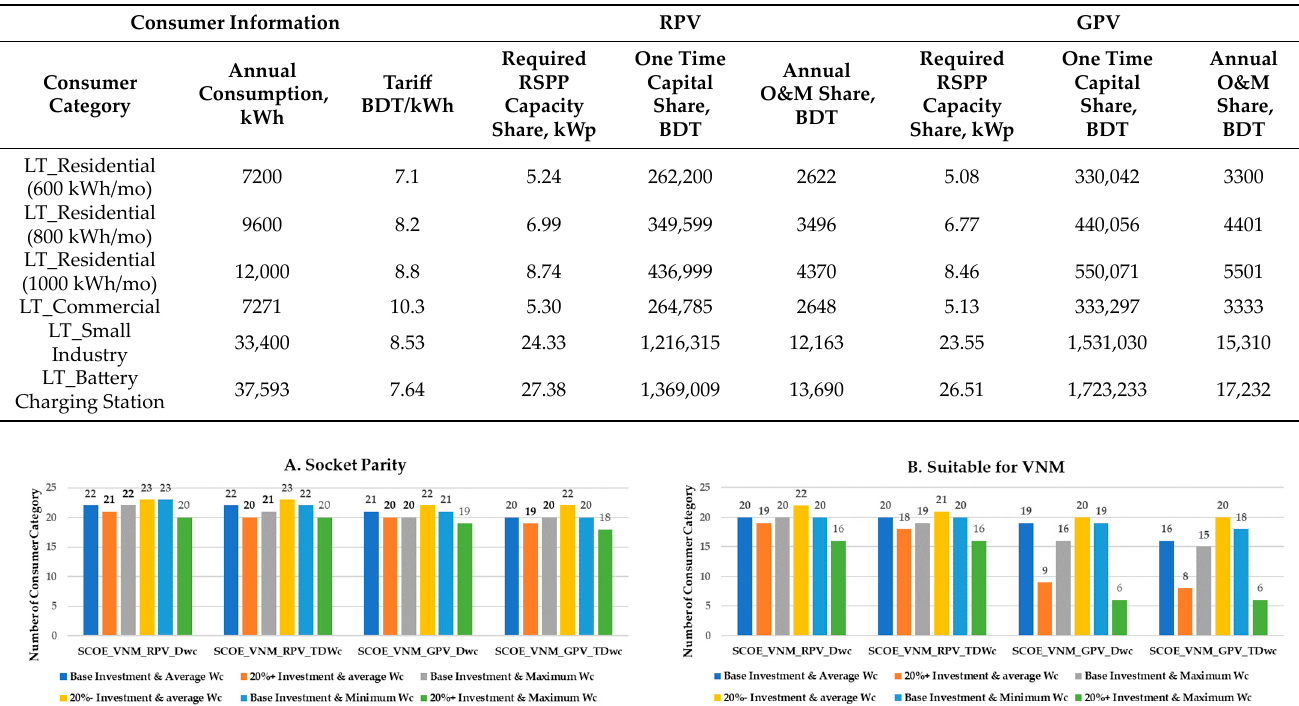
Figure 9. Impacts of investment and wheeling costs on socket parity. The base investment costs for RPV and GPV were 50,000 and 65,000 BDT/kWp, respectively. Additionally, the base wheeling costs for DWc and TDWc were 1.55 and 1.86 BDT/kWh, respectively. The minimum and maximum wheeling costs came from the wheeling costs of all the utilities in Bangladesh.